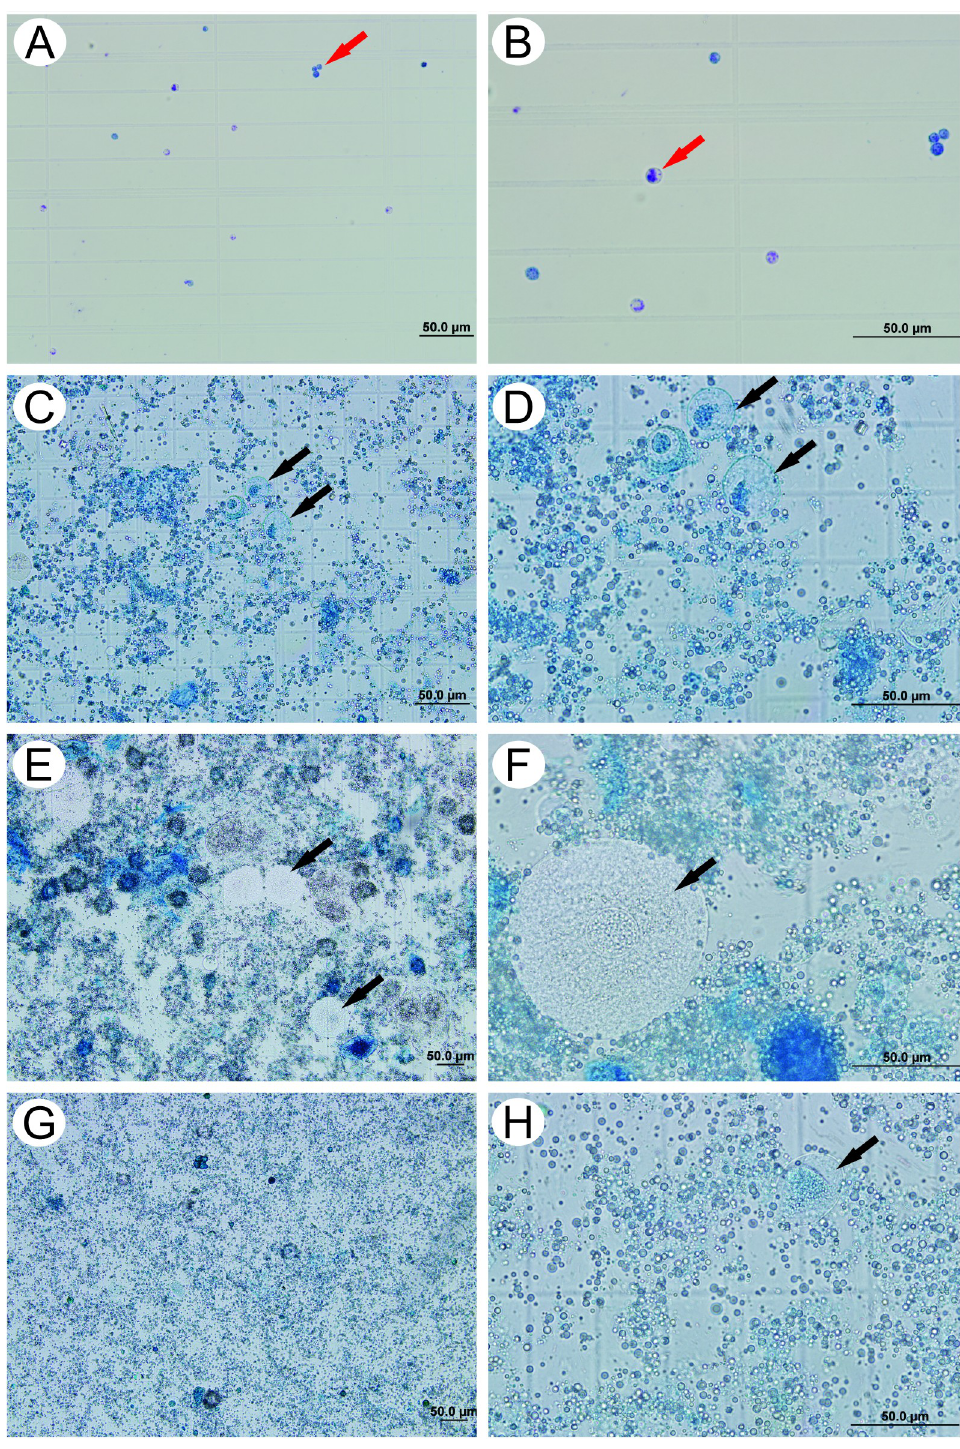
Fig 4. Photomicrographs of Neubauer chambers containing hemolymph samples from fifth instar larvae of A . mellifera obtained using different extraction techniques and stained with methylene blue 0.2%. (A) Ophthalmic scissors extraction at 200x magnification; (B) Ophthalmic scissors extraction at 400x magnification (C) 30-G needle extraction at 200x magnification; (D) 30G needle extraction at 400x magnification; (E) Fine-tipped forceps extraction at 100x magnification; (F) Fine-tipped forceps extraction at 400x magnification; (G) Hypodermic syringe extraction at 100x magnification; (H) Hypodermic syringe extraction at 400x magnification. Black arrows indicate fat body cells. Red arrows indicate hemocytes. https://doi.org/10.1371/journal.pone.0234637.g004 PLOS ONE | https://doi.org/10.1371/journal.pone.0234637 June 18,